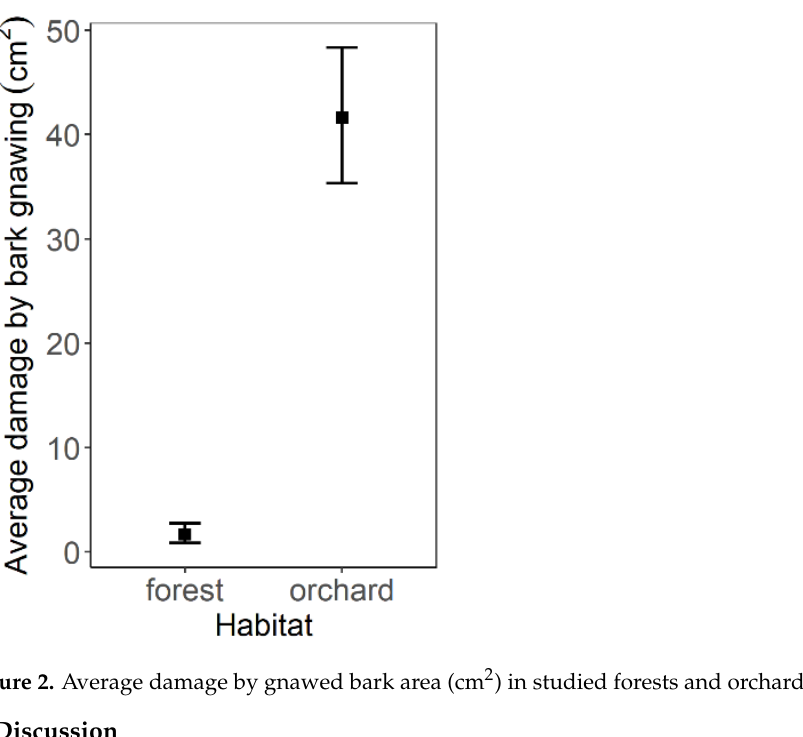
Figure 1. Proportion of damaged trees in studied forests and orchard in 2019.